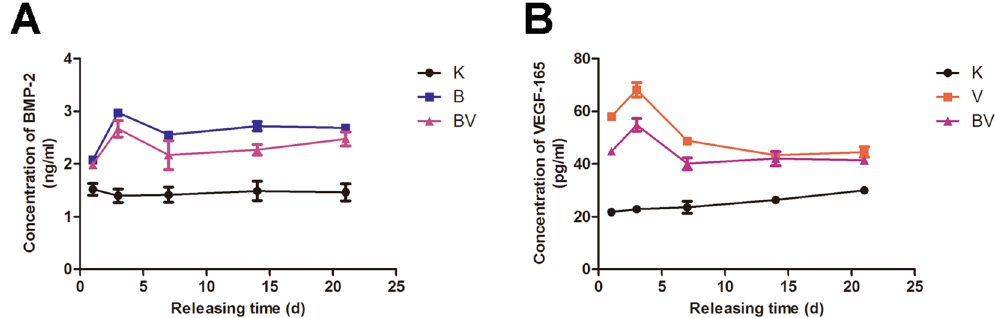
Figure 3. ( A ) BMP-2 release in PBS of different groups for 21 days, ( B ). VEGF-165 release in PBS of different groups for 21 days. In the figure K represents control group- pure hydrogel, B for BMP-2 loaded-hydrogel, V for VEGF-165 loaded-hydrogel and BV for hydrogel loaded with both BMP-2 and VEGF-165.